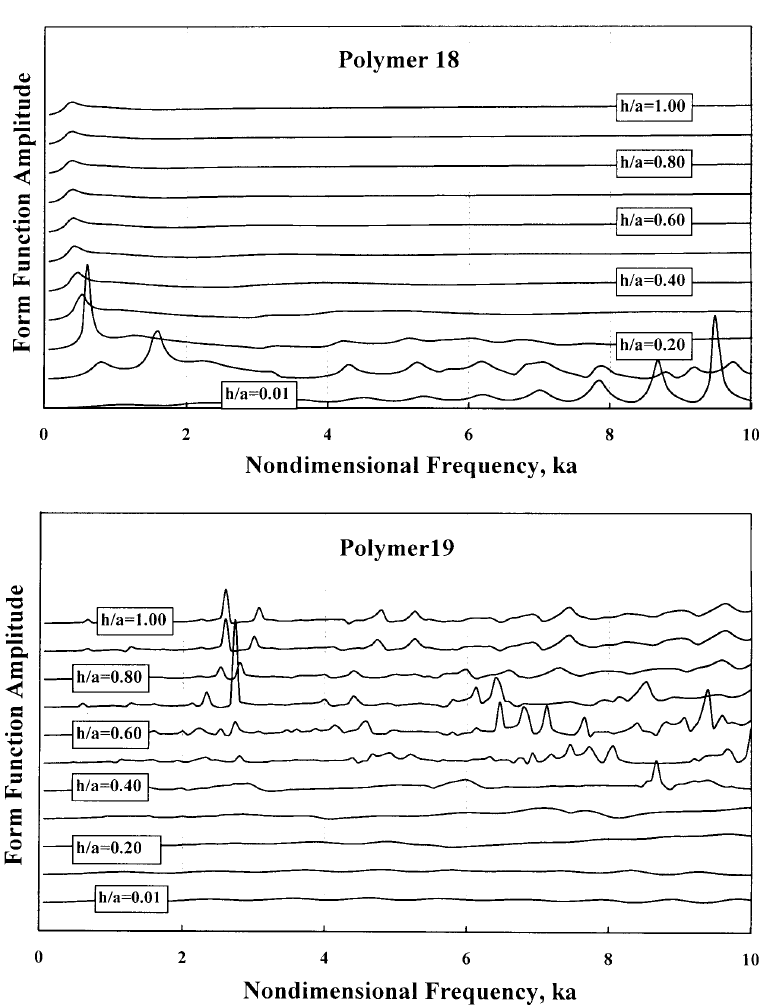
Fig. 3. Variation of the form function for the fluid-filled spherical viscoelastic shell with changes in shell